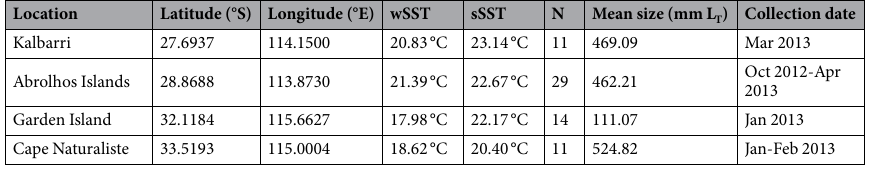
Table 1. Collection and sample details including study locations with geographic coordinates, average sea- surface temperature during winter (wSST °C) and summer (sSST °C) (2002–13), total number of fish collected (N), mean fish size (mm total length, L T ) and collection date. Temperature data from MODIS-AQUA satellite (Goddard Earth Sciences Data and Information Services Center GES DISC,